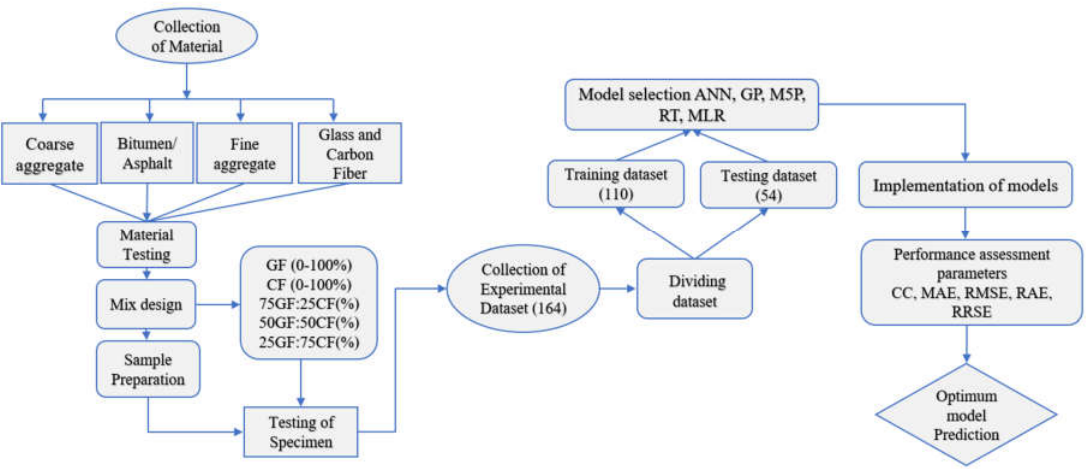
Figure 2. Flowchart showing the detailed methodology of the present study.